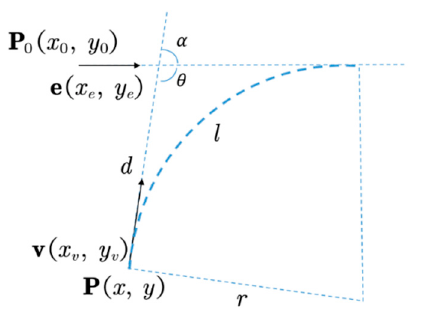
Figure 9. Desired velocity update algorithm.